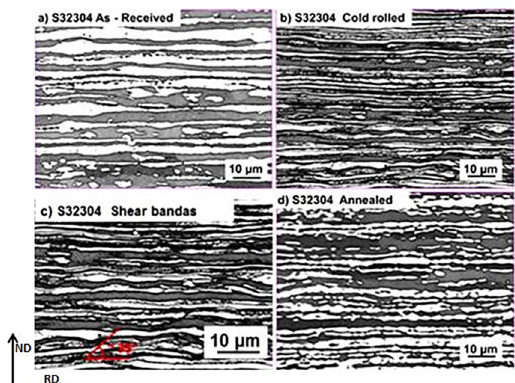
Figure 2. Microstructure of the duplex stainless steels S32205; a) as received, b) cold rolled (CR) and c)